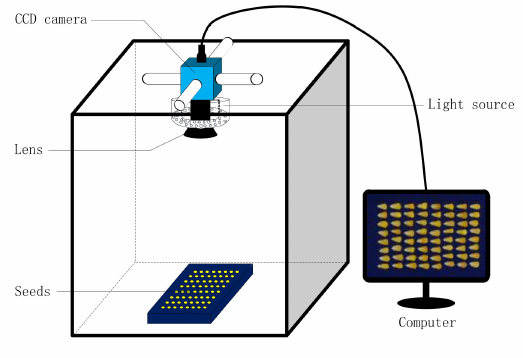
Figure 2. Optical image acquisition system.